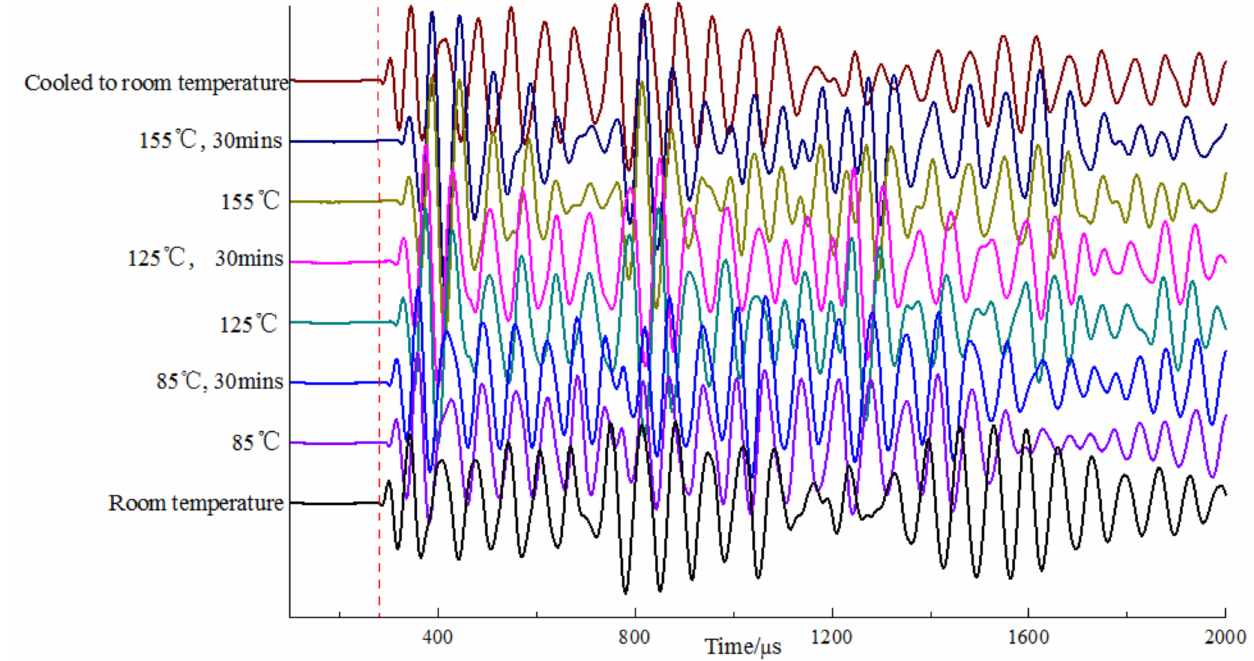
Figure 11. Time domain waveforms received by the receiver in the normal temperature area, when a piezoelectric vibrator transmits pulse acoustic waves at different